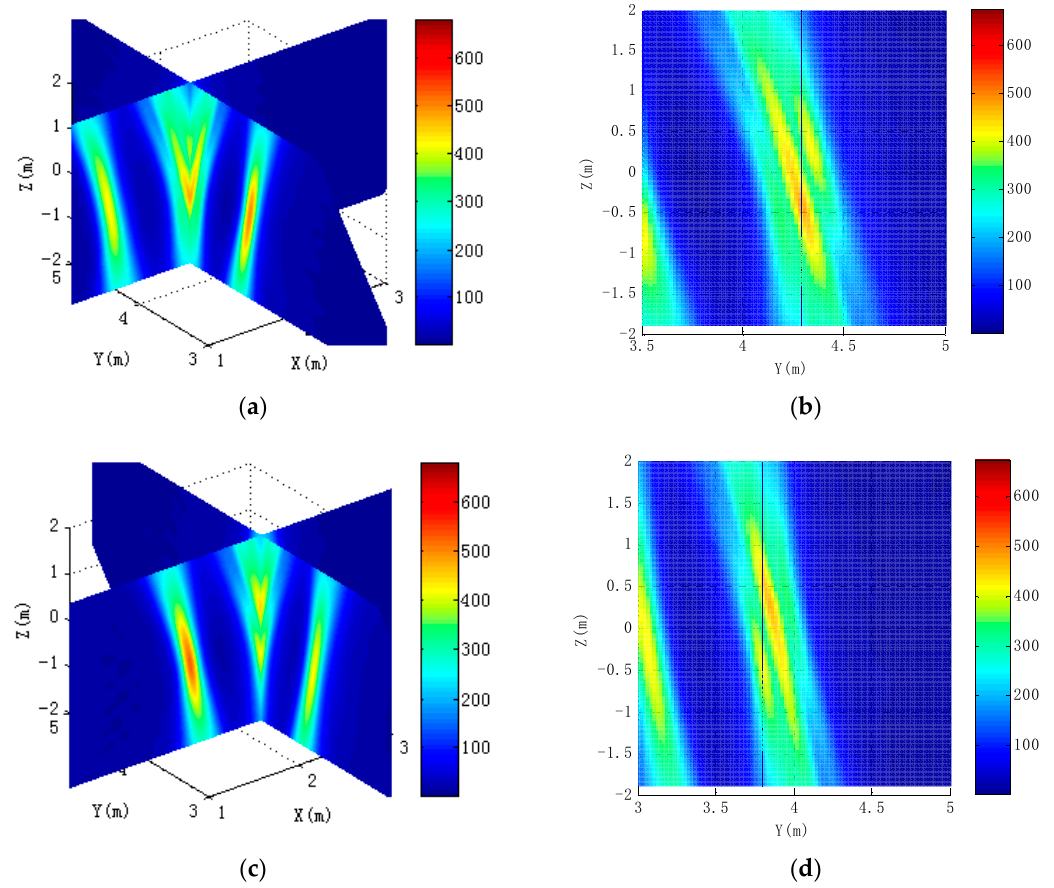
Figure 12. Distribution of scattering centers on empennage trailing edge tips. ( a ) Imaging results of the 15th and 16th scattering centers; ( b ) The section of the 15th and 16th scattering centers in the XZ plane; ( c ) Imaging results of the 17th and 18th scattering centers; ( d ) The section of the 17th and 18th scattering centers in the YZ plane.